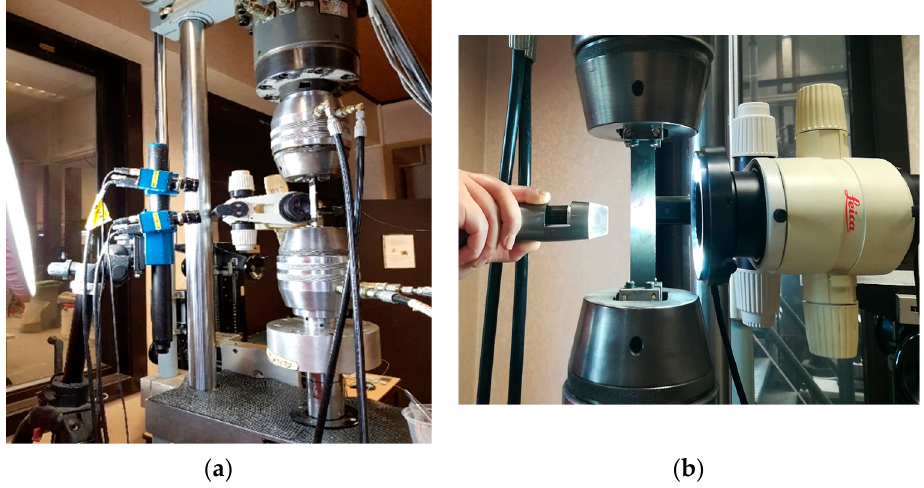
Figure 3. ( a ) Experimental set-up and ( b ) microscopes for damage monitoring.